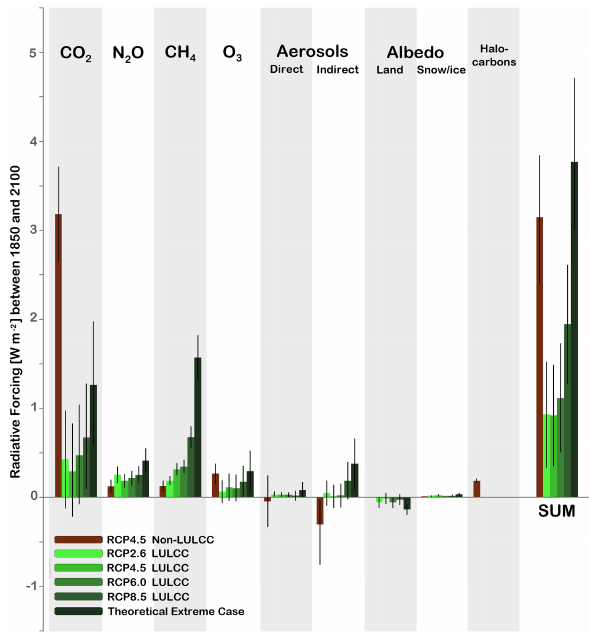
Figure 4. RF for all LULCC and non-LULCC anthropogenic im- pacts (RCP4.5 Non-LULCC) estimated by this study for the year 2100, referenced to the year 1850. Error bars show 1 σ uncertainties as computed in this study (Table 2). The “SUM” bars show the total RF when all forcing agents are